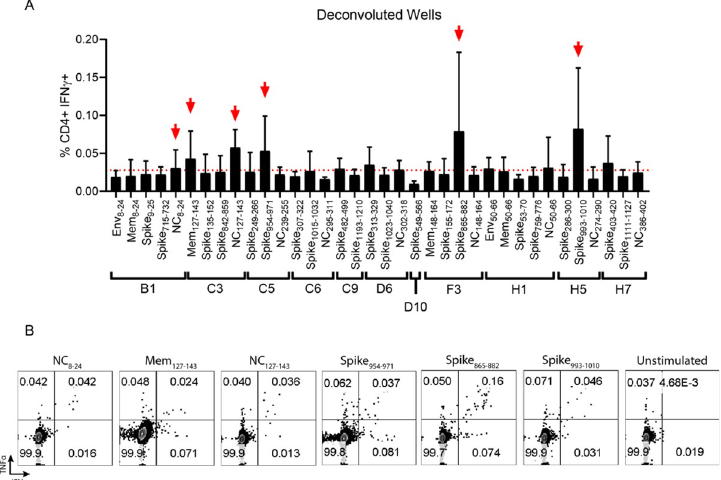
Fig 5. In vivo transfection of hACE2 mRNA permits the detection and functional mapping of SARS-CoV-2 specific CD4 + T cell responses. ( A ) As potential “well” hits were identified, the peptides contained in each well were deconvoluted and used individually to stimulate splenocytes from hACE2 transfected, SARS-CoV-2 infected mice. 6 potential epitopes were identified (marked with red arrows) as defined by the frequency of IFN- γ + CD4 + T cells being at least 2-fold above background (stimulated with vehicle) in at least 3 of the 4 mice screened. ( B ) Representative flow cytometry plots displaying IFN- γ and TNF α expression in CD4 + T cells for each putative epitope in comparison to a vehicle